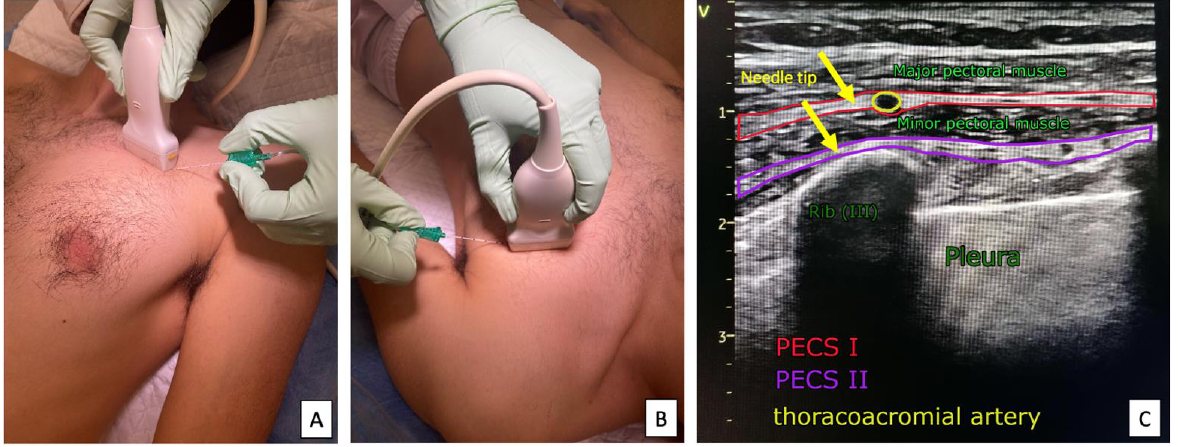
Figure 4. Ultrasound transducer positioning of the PECS I ( A ) and PECS II ( B ) blocks and sonoanatomy of the PECS blocks ( C ). Table 1. Local anesthetic volumes used for described blocks.